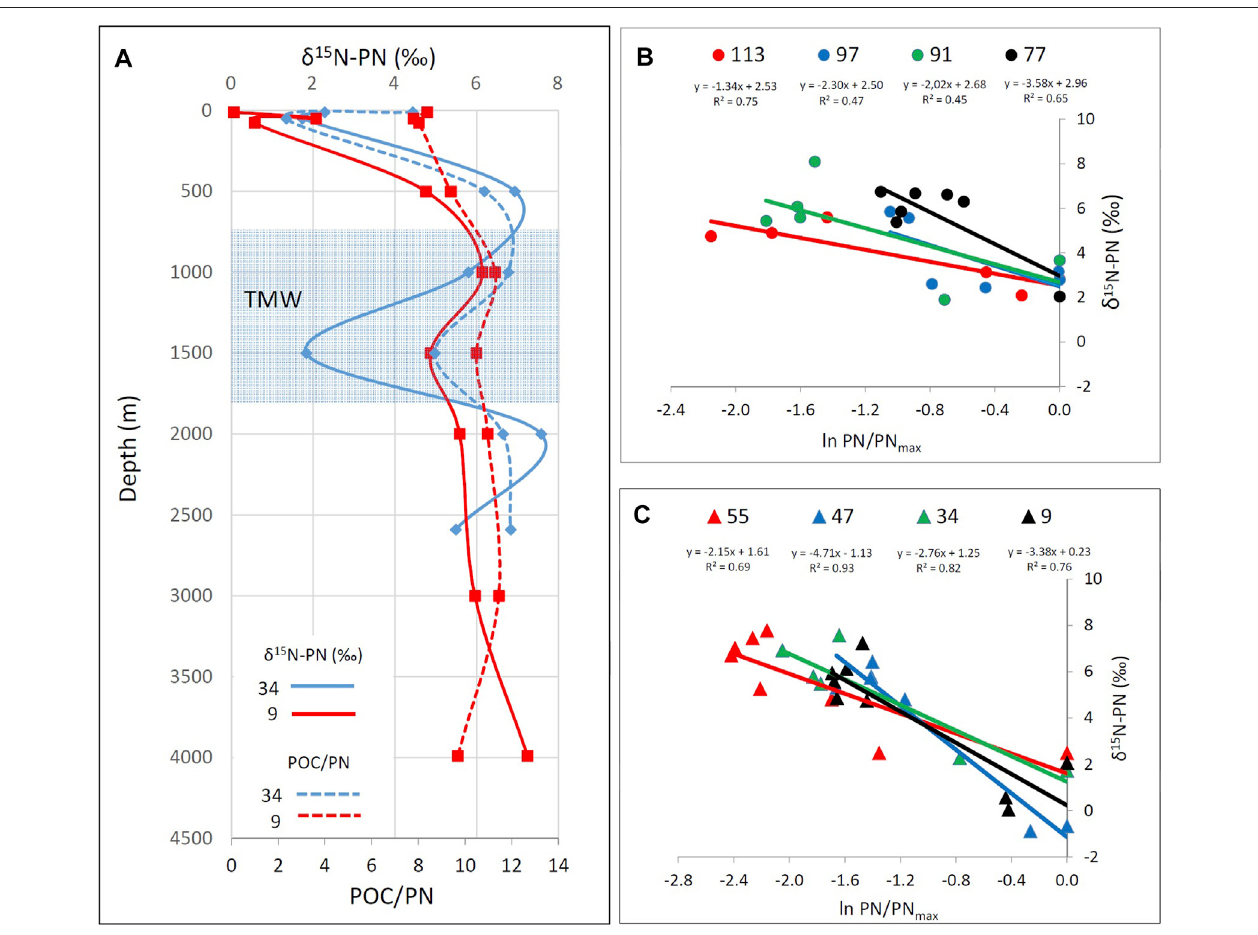
FIGURE8| Verticalpro fi lesof δ 15 N-PN(in ‰ ;solidlines)andPOC/PNratio(dottedlines)forstations34(bluelines)and9(redlines)showingoutlierswithintheTMW mass (A) . PNconcentrations per liter, normalized tomaximum PN concentrationsof surface waters (10 m or DCM depth for each station, except ofstation 97 forwhich the max PN values were observed in subsurface waters) vs δ 15 N-PN (in ‰ ) for pelagic stations in the WMed (B) and EMed (C) respectively, indicating Rayleigh-type isotope fractionation. The fractionation factors 15 ε calculated from the slope of the logarithmic functions and r 2 signi fi cance in all cases show a clear tendency towards stronger fractionation in the EMed (2.15 – 4.71 ‰ ) compared to the WMed (1.34 – 3.58 ‰ ). Y-intercepts indicate initial δ 15 N values of the substrate (from − 1.13 to 2.97 ‰